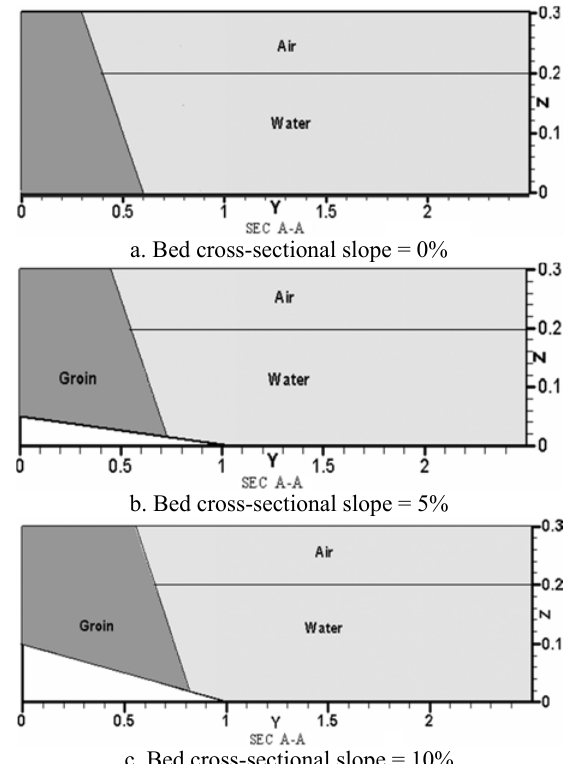
Fig.5 Geometry shapes of cross-sectional for the vertical groyne